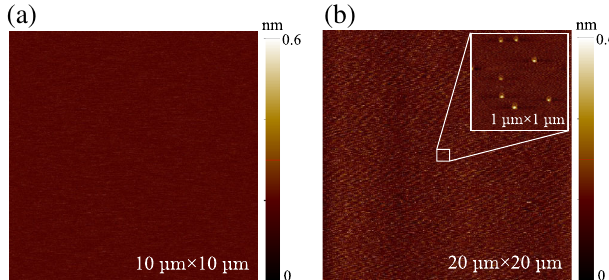
FIG. 5. (a) Mica surface scanned by a noncontact mode commercial AFM (NX-10, Park Systems) with a commercial cantilever tip (2 nm radius of curvature; SSS-NCLR-10, Nano- sensors Co.). The mica surface was equilibrated in an airtight chamber for over one day, which is the same condition as we used for our capillary condensation experiments in this paper. After randomly scanning different areas on the surface, we found that no contaminants exist over a 1000 μ m 2 scan area. Mica was prepared using the tape-cleaving method, which is well known to produce the cleanest mica surface [31]. (b) Mica surface that was placed in airtight chamber for over 14 days. We found high concentration of contaminants scattered over the mica surface. The inset clearly shows adventitious